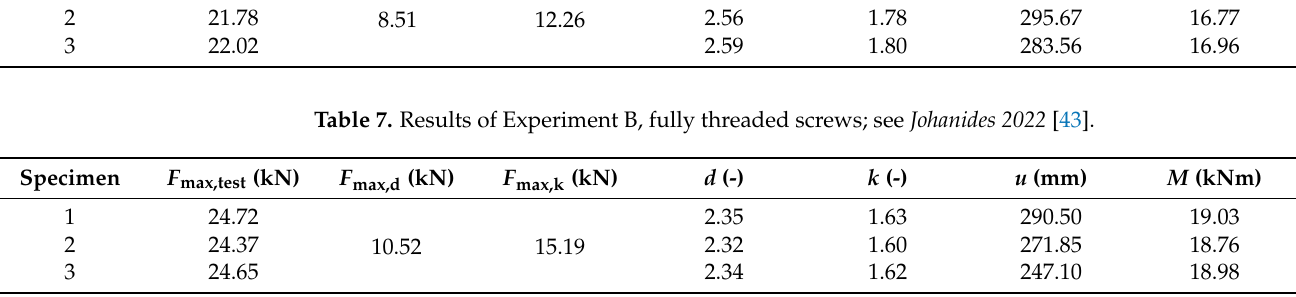
Figure 15. Experiment B: Load–deformation curves of destructive quasi-static cyclic testing for individual specimens made from fully threaded screws.